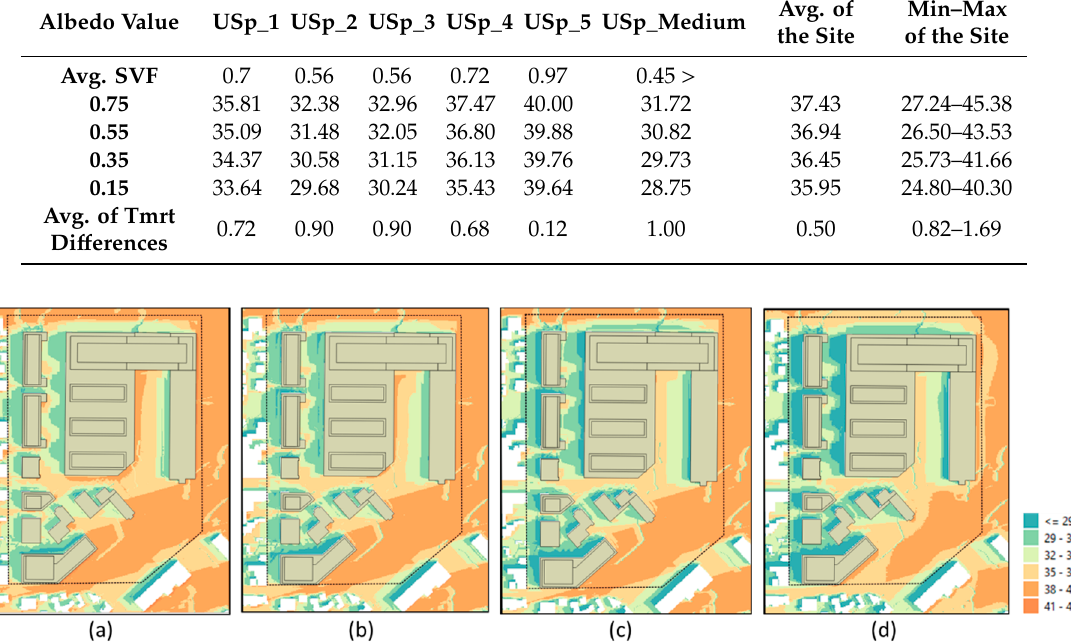
Figure 9. Spatial distribution of mean daytime Tmrt using different wall surface albedo from high to low value: ( a ) albedo = 0.75; ( b ) albedo = 0.55; ( c ) albedo = 0.35; ( d ) albedo = 0.15.3.2. The Spatiotemporal Distribution of Tmrt and Identification of Hot-Spots.